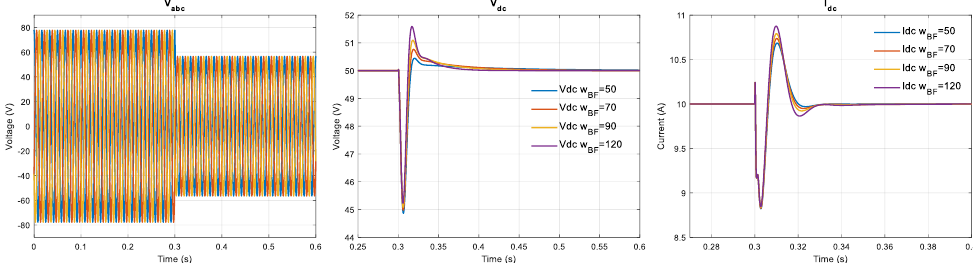
Figure 9. Simulation results when the rms grid voltage drops from 55 V to 40 V with an ouptut voltage regulation at 50 V: grid voltages V abc on the ( left ), output voltage V dc in the center, and output current I dc on the ( right ). Parameters are listed in Tables 1 and 3.